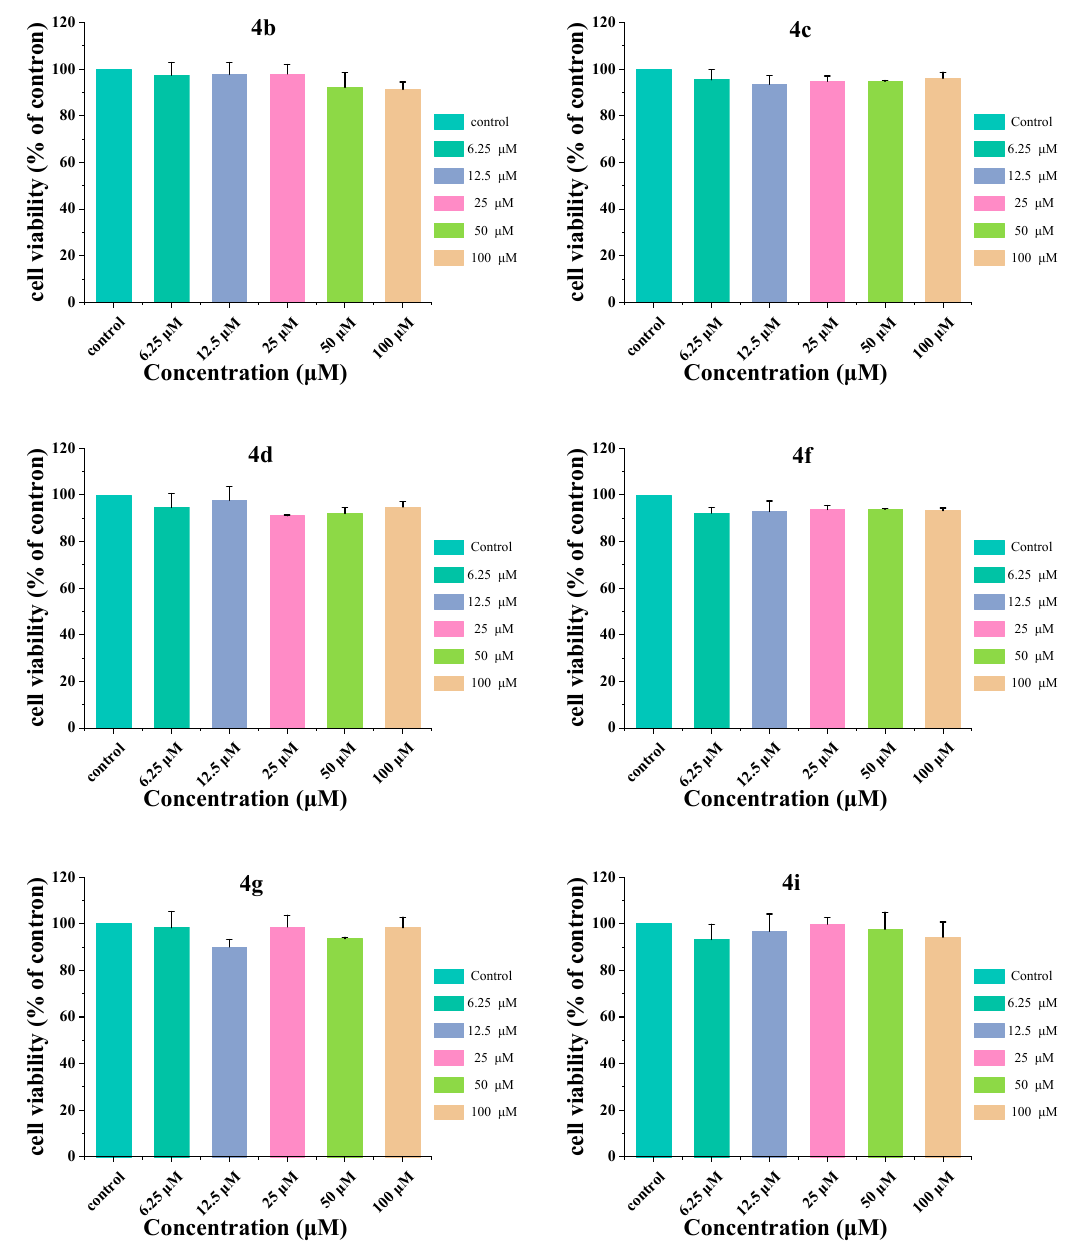
Figure 2. The effect of benzothiazole–isoquinoline derivatives ( 4b , 4c , 4d , 4f , 4g , 4i ) on the prolifera- tion of L929 cells (MTT method).